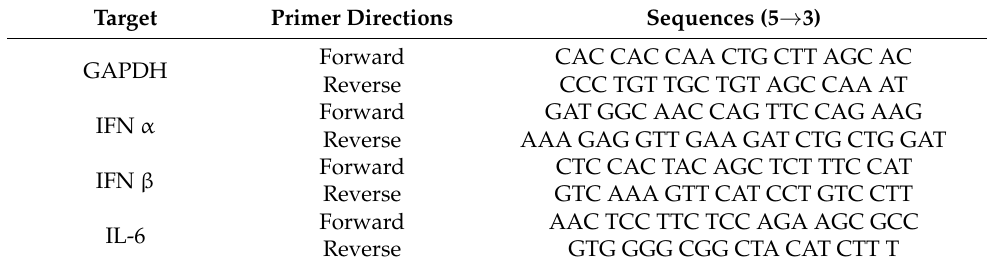
Table 1. List of primers used in